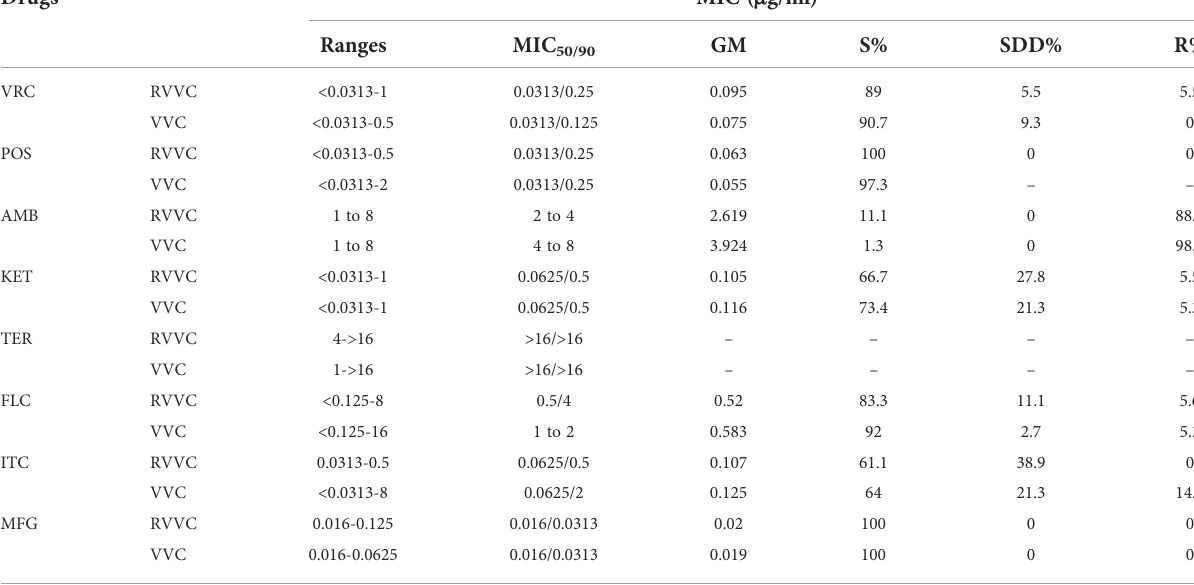
TABLE 3 The in vitro antifungal susceptibility of C. albicans isolated from patients with RVVC or VVC to eight antifungal drugs.